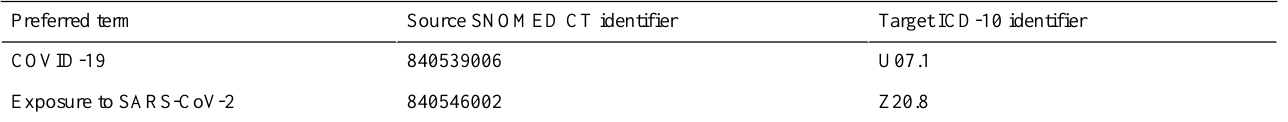
Table 5. SNOMED CT (SNOMED Clinical Terms) to ICD-10 (International Classification of Diseases, Tenth Revision)